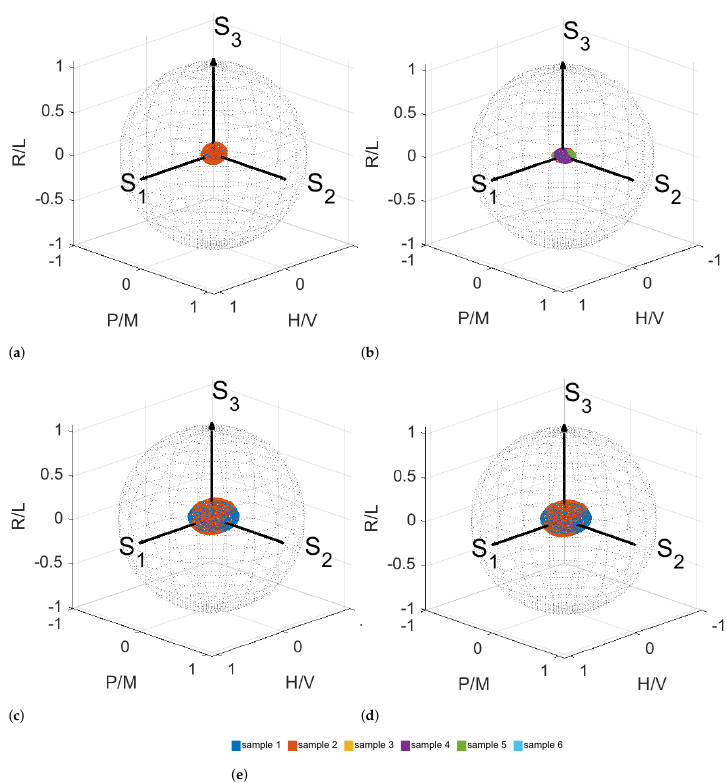
Figure 9. Poincaré sphere with every measurement included in the same sphere. Surfaces in the Poincaré sphere for measurement conditions I ( a ), II ( b ), III ( c ) and IV ( d ). ( e ) Color 4. Summary and Outlook In this work, we reported MM measurements on non-planar collagen containing animal tissue, i.e., ex vivo porcine corneas. We developed a setup which allowed for the investigation of such samples in transmission and reflection mode capable of spatially resolving the inhomogeneities of the sample or the effect of photo-induced processes. The application of riboflavin followed by UV exposure along the Dresden protocol leads to noticeable changes in the MM entries indicating that these can be correlated with the photo-induced cross-linking. Furthermore, we found that the careful choice of the region- of-interest segmentation, i.e., removing overexposed areas as well as bright patches on the surface originating from impurities, leads to an improved analysis. The polarization decomposition metrics point towards changes induced by the CXL. This indicates that the resultsofsubtleprocessesoccurringinsuchmediacanbeobservedusingnon-invasiveMM